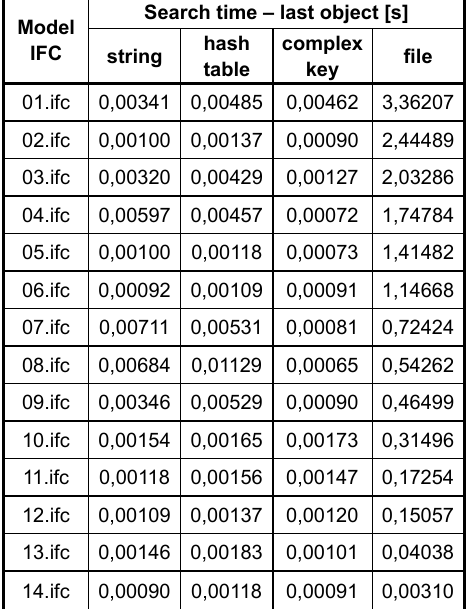
Tab. 11. List of last objects reading times in test mod- els from the database in each of the three proposed data models and from a text file